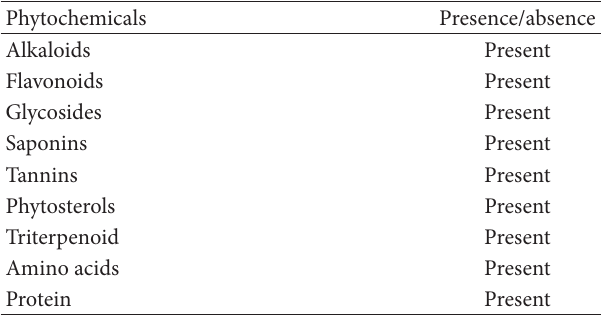
Table 1: Phytochemical constituents of Triticum aestivum extract.